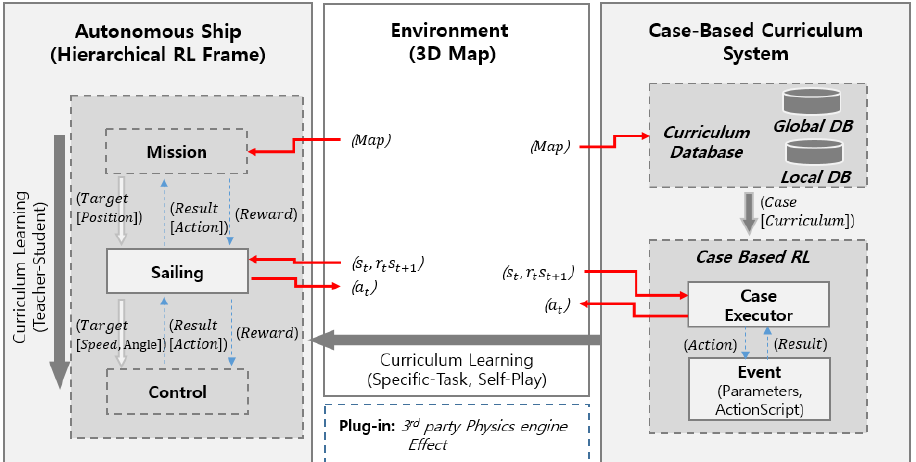
Figure 1. ILFAS scheme. Autonomous ship, hierarchical RL algorithm, case-based curriculum system building the curriculum and operating neighboring ships through cased-based RL, 3D geographical environment with a certain height and learning environment integrate the elements above. The environment and plug-in can be replaced by other simulations.